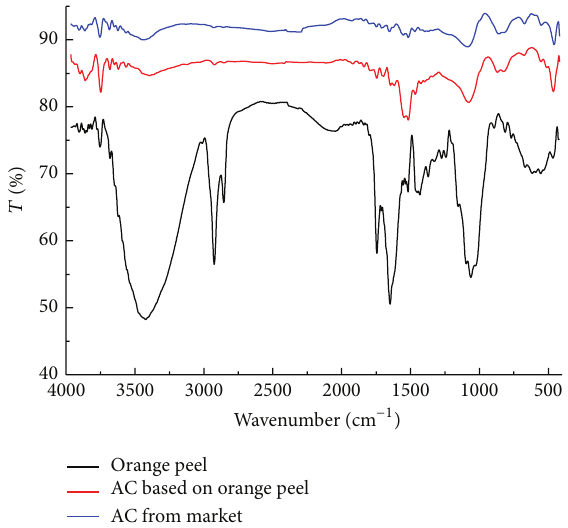
Figure 3: FT-IR spectrum of orange peel and activated carbon samples.